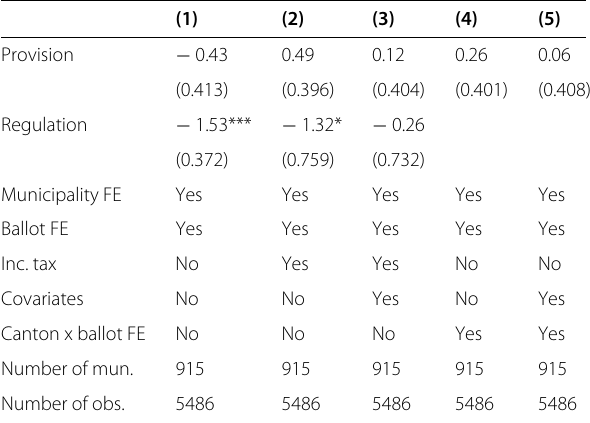
Table 4 Effect of lunchtime and after-school care on vote outcomes on healthcare-related